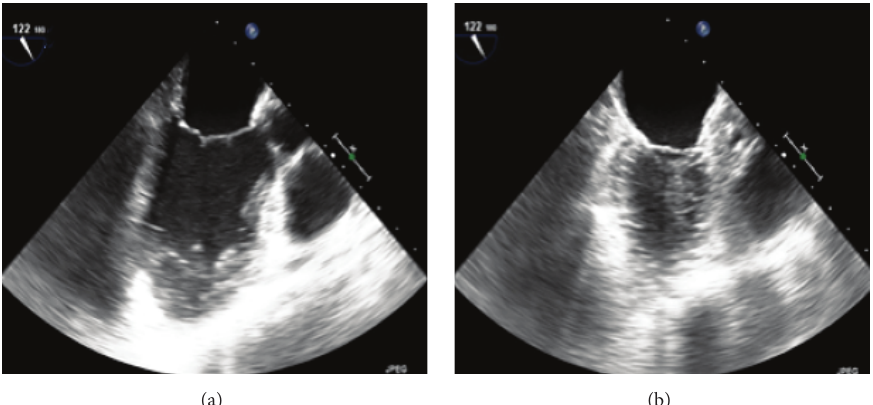
Figure 2: Transesophageal echocardiogram while off pentobarbital infusion, left ventricle ejection fraction of 50%: (a) end diastole; (b) end